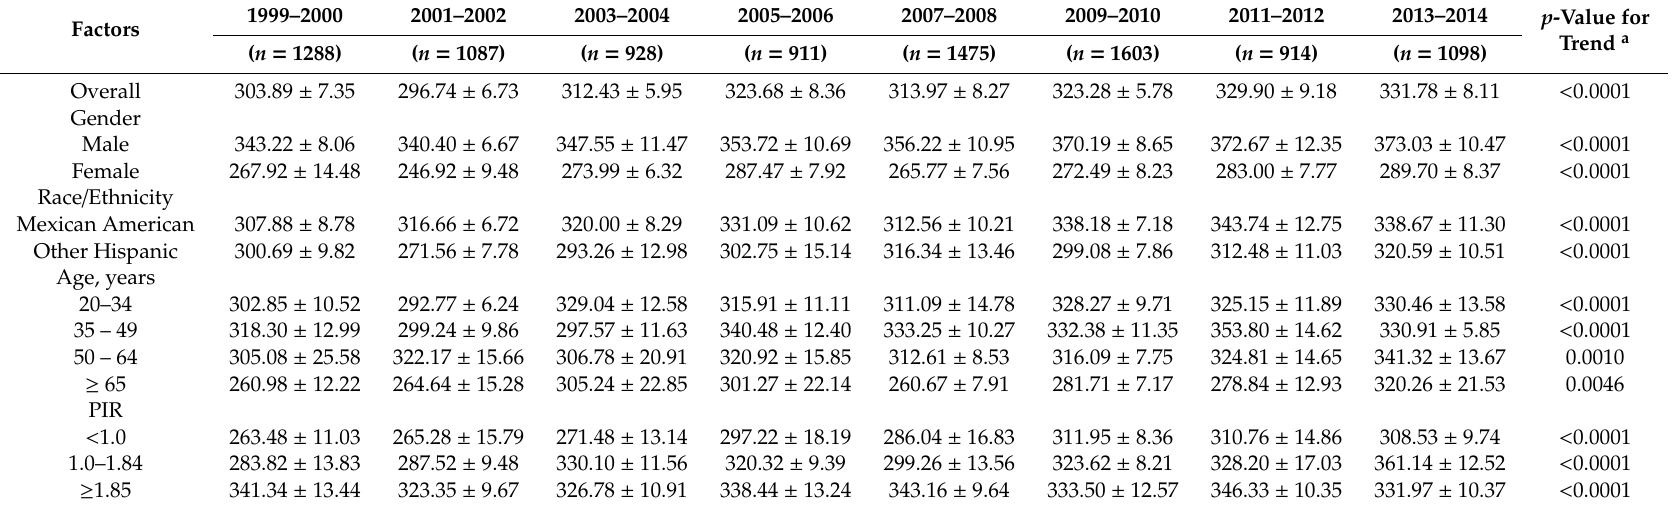
Table 3. Trends in total magnesium intake (mg / day) among Hispanic adults aged ≥ 20 years, the National Health and Nutrition Examination Survey (NHANES) 1999–2014* ( n =